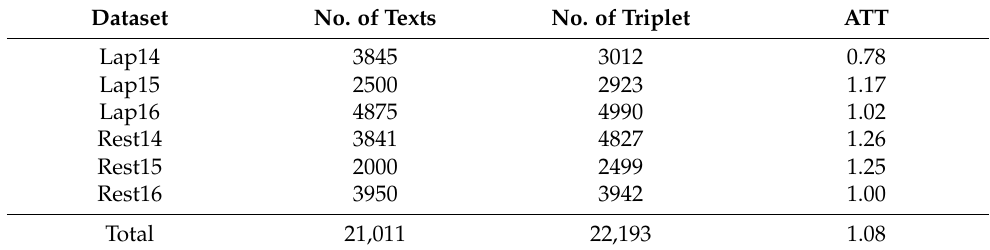
Table 1. Statistics of the datasets.